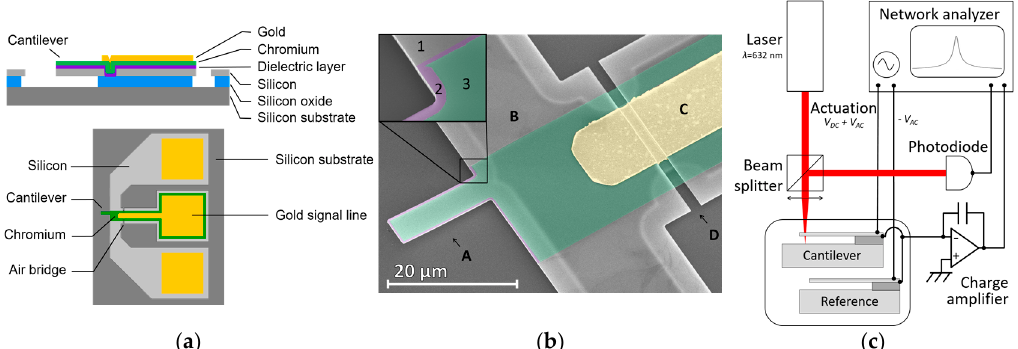
Figure 1. ( a ) Schematic cross-section (top) and top view (bottom) of a micro-cantilever; ( b ) Scanning electron microscope image of a fabricated device. A denotes the cantilever, B its anchor area connected to the charge amplifier, C the gold signal line, D the air bridge. Inset: close view of the junction of the cantilever with its anchor where 1 indicates the silicon structural layer, 2 the silicon nitride layer and 3 the chromium layer; ( c ) Optical and electrical measurement set-up of the device resonance frequency response.